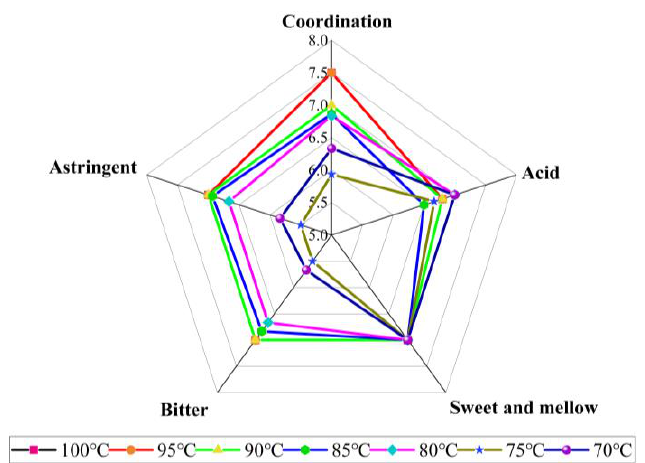
Figure 4. Radar chart of ODT flavor factor scores at different fixing temperatures.